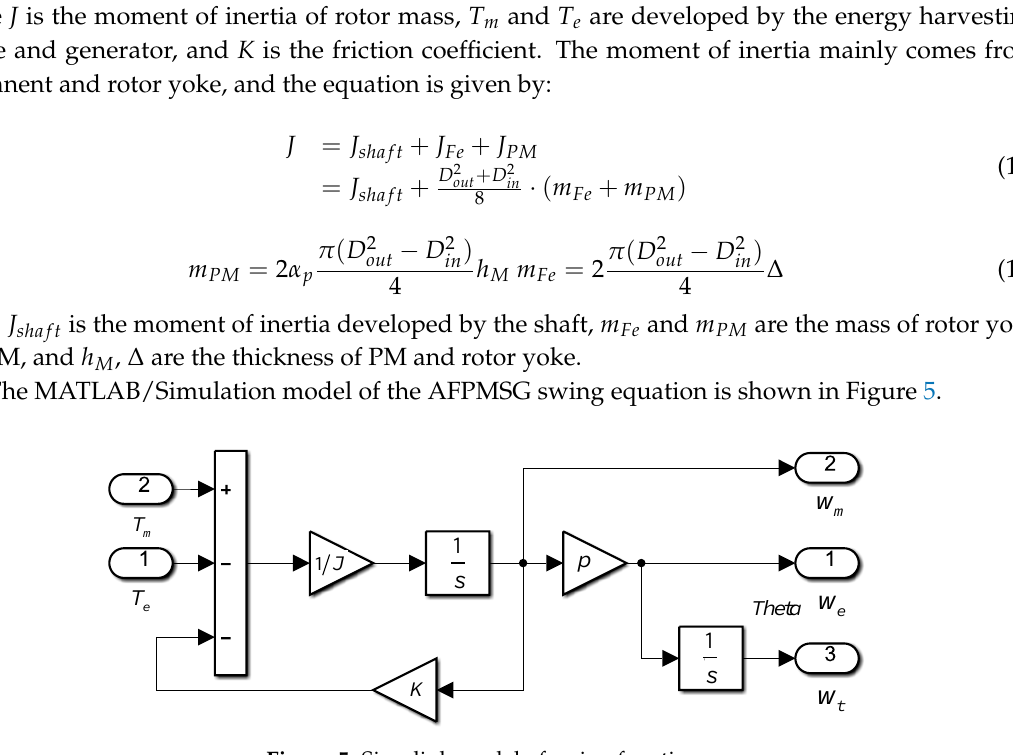
Figure 5. Simulink model of swing function.